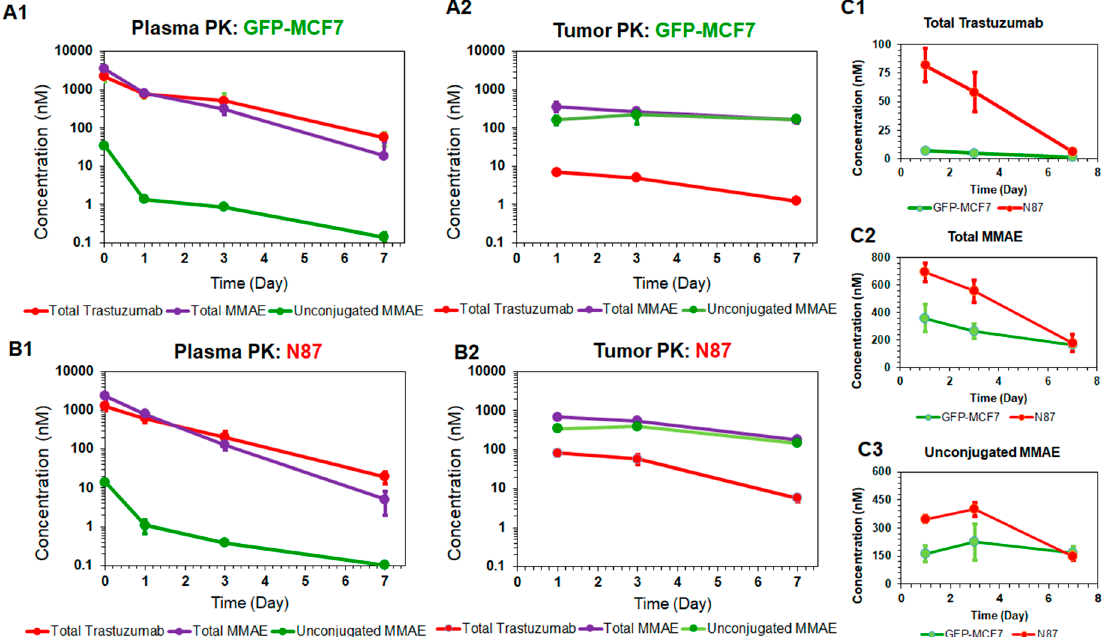
Figure 2. Plasma and tumor pharmacokinetic data (mean ± standard deviation) for three analytes ( n = 3): unconjugated MMAE (green), total MMAE (purple), and total trastuzumab (red), after 10 mg/kg intravenous dose of T-vc-MMAE in GFP-MCF7 ( A1 and A2 ) and N87 ( B1 and B2 ) tumor bearing mice. Comparative tumor pharmacokinetics of 10 mg/kg T-vc-MMAE in GFP-MCF7 (green) and N87 (red) tumors for total trastuzumab ( C1 ), total MMAE ( C2 ) and unconjugated MMAE ( C3 ).